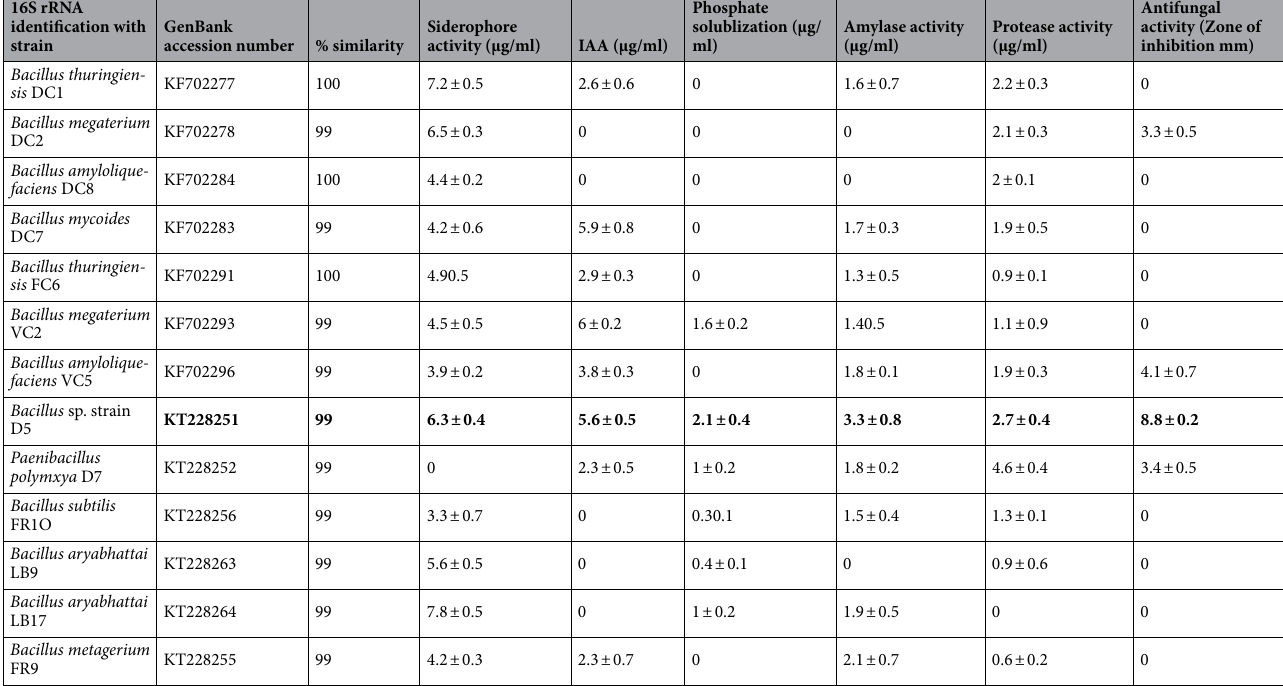
Table 1. Quantitative analysis of plant growth promoting properties and antifungal potential of selected 13 short listed Bacillus